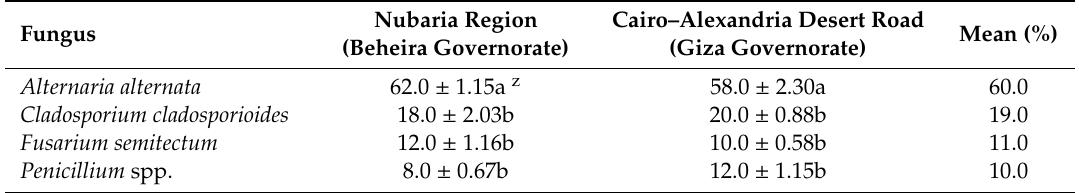
Table 2. Frequency (%) of fungal species from naturally infected ‘Anna’apple fruit collected from di ff erent locations in Beheira and Giza Governorates, Egypt.